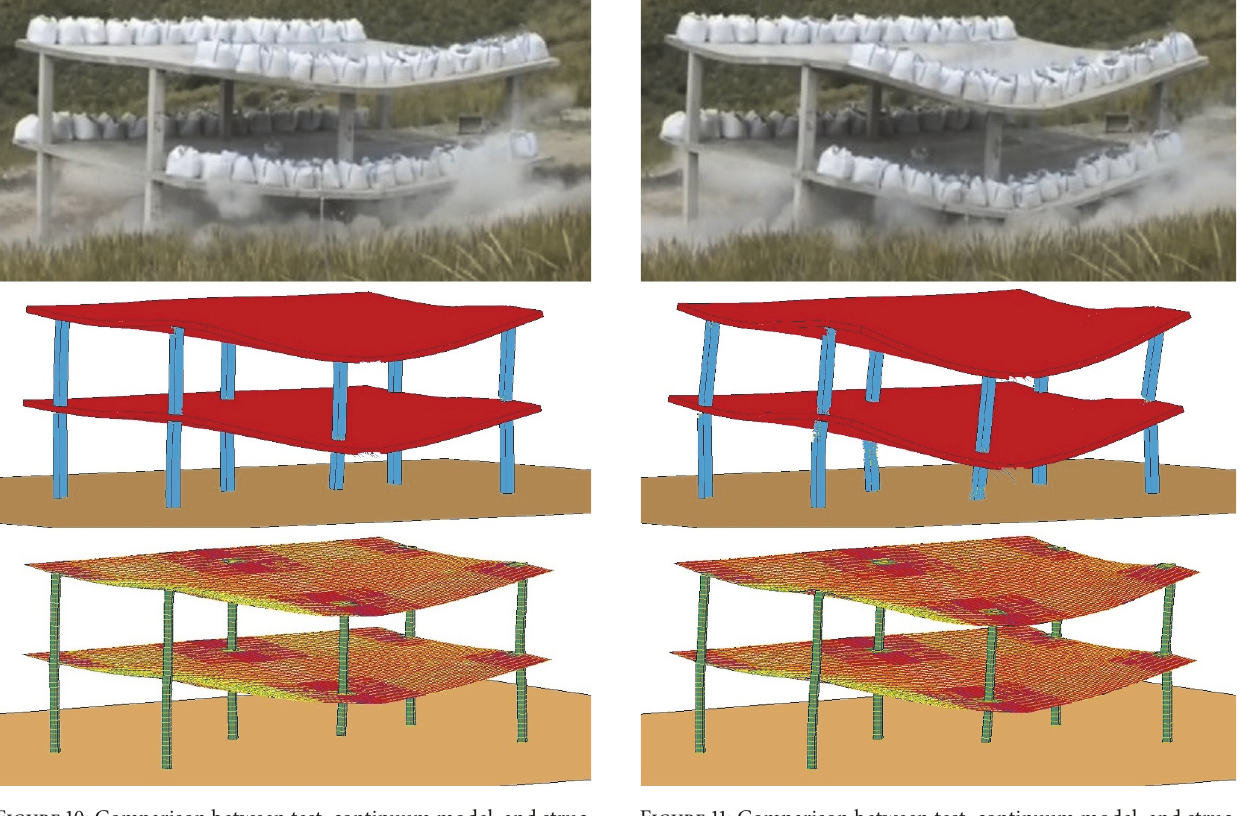
Figure 10: Comparison between test, continuum model, and struc- tural model at 0.6 s after column removal.